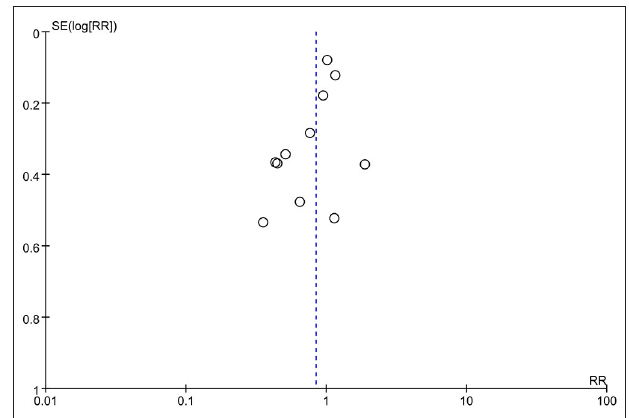
FIGURE 4 | Funnel plot of the primary outcome (the incidence of PNDs).